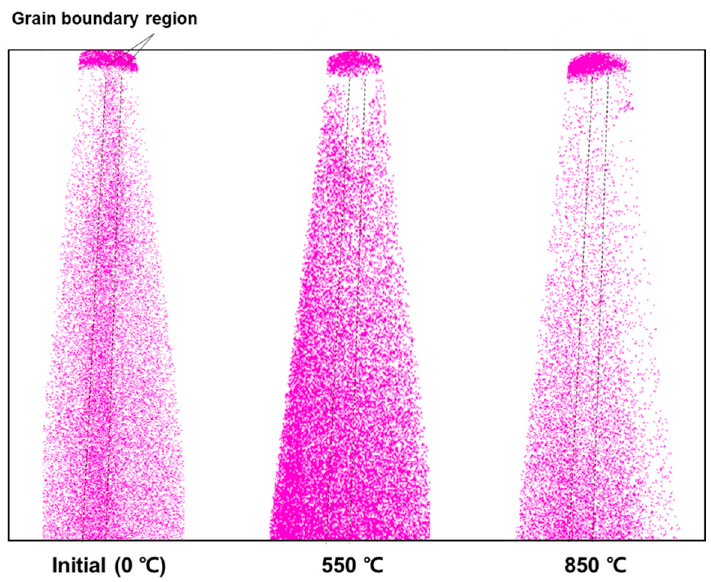
Figure 7. Hydrogen distribution obtained by an atom probe tomography (APT) measurement in the grain boundary area at 0 °C (initial), 550 °C, and 850 °C. The dotted line indicates the grain boundary area.